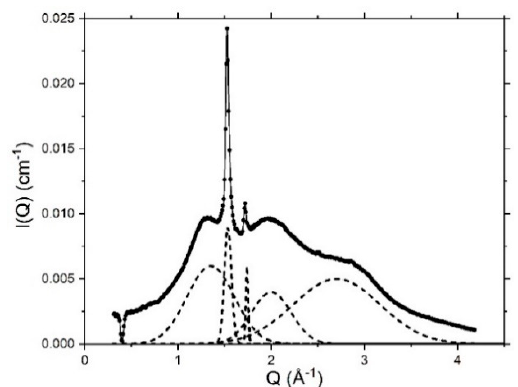
Figure 8. WAXS profile (solid line) measured at 298 K for a 10% cream prepared with octadecanol (C6) as co-surfactant and the deconvolution of the profile (dotted line) revealing peaks corresponding to lateral spacings (left to right) of 4.65 Å, 4.11 Å, 3.70 Å, 3.12 Å and 2.36 Å. Formulation composition is provided in Methods, Table